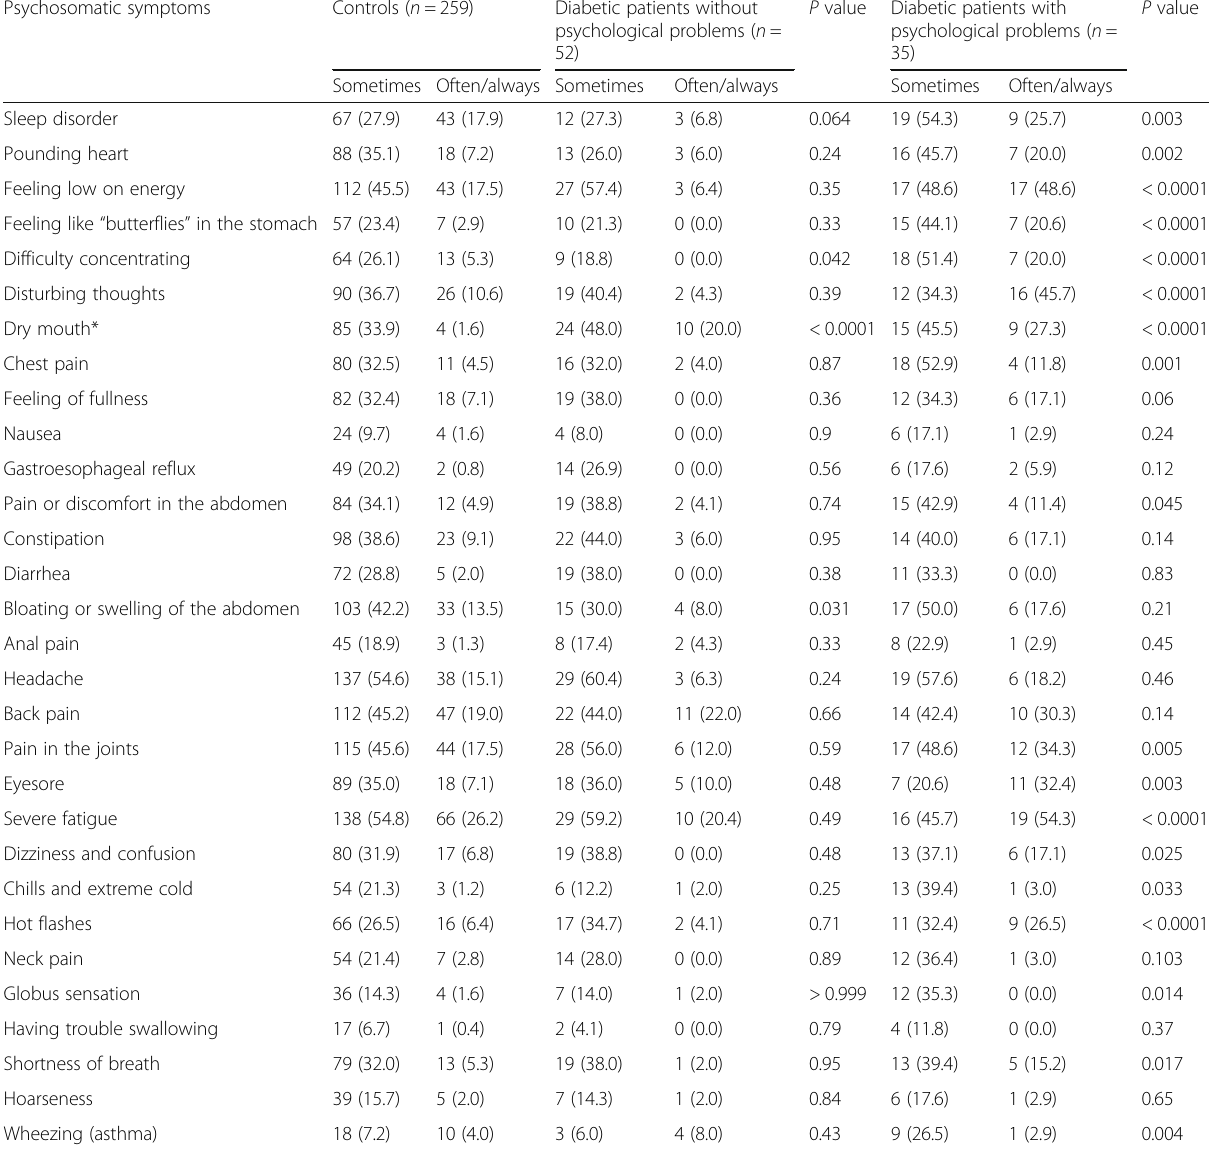
Table 2 Prevalence of psychosomatic symptoms in diabetic patients and controls Psychosomatic symptoms Controls ( n = 259) Diabetic patients without